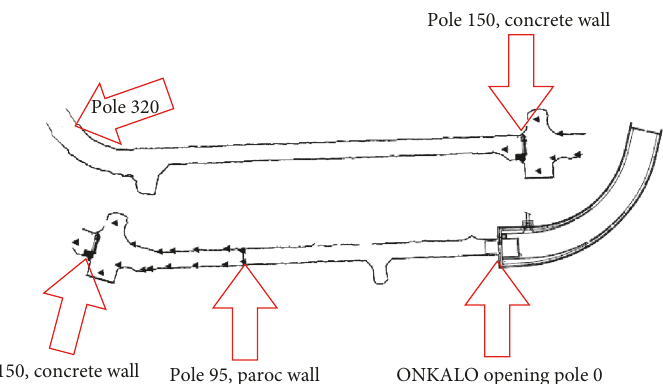
Figure 10: Measurement configuration 1.